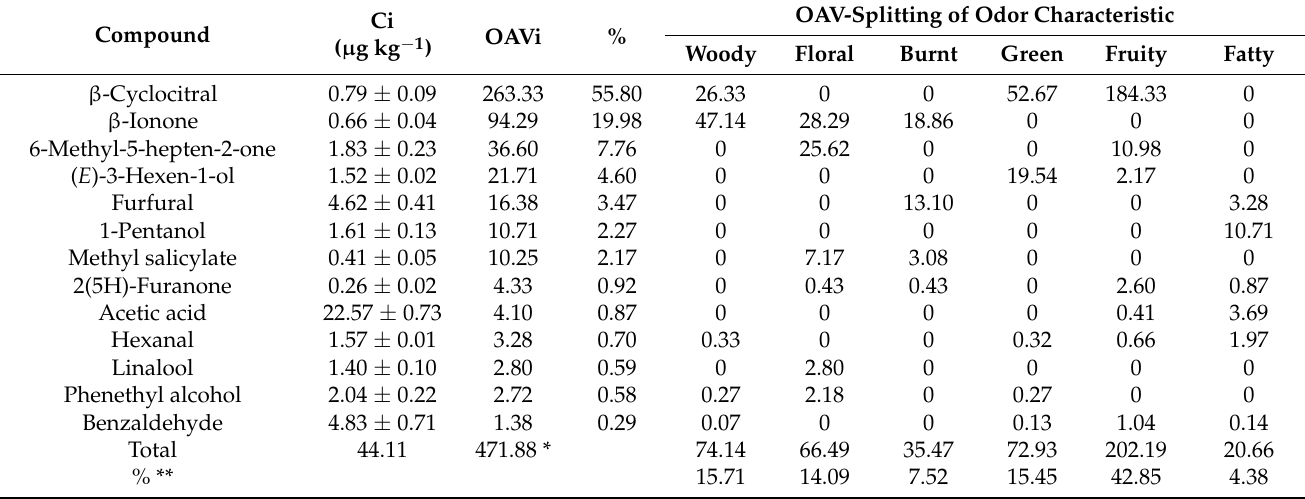
Table 4. The content, OAVi and OAV-splitting of key aroma compounds in red